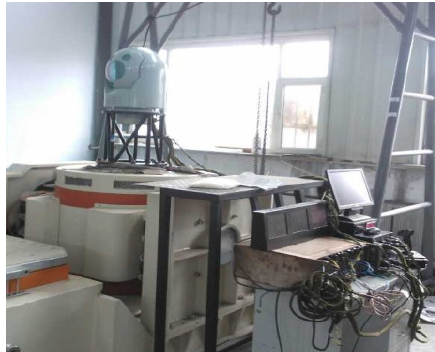
Fig. 2 Indoor test of the airborne PAT